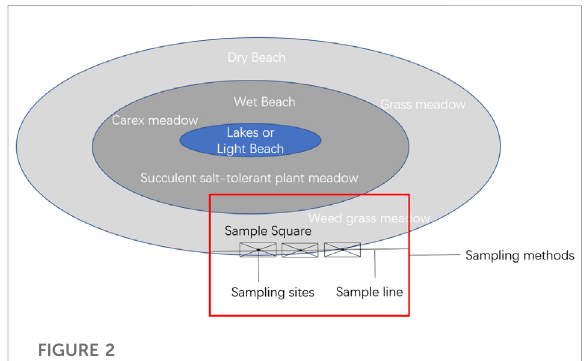
FIGURE 2 Sampling method and meadow ring distribution map.